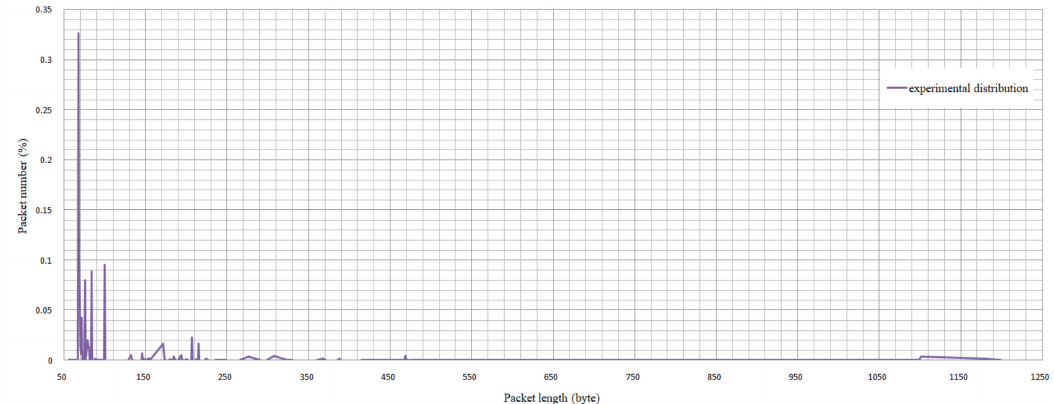
Figure 8. A diagram of the dependence of the packet number (%) on the packet length.